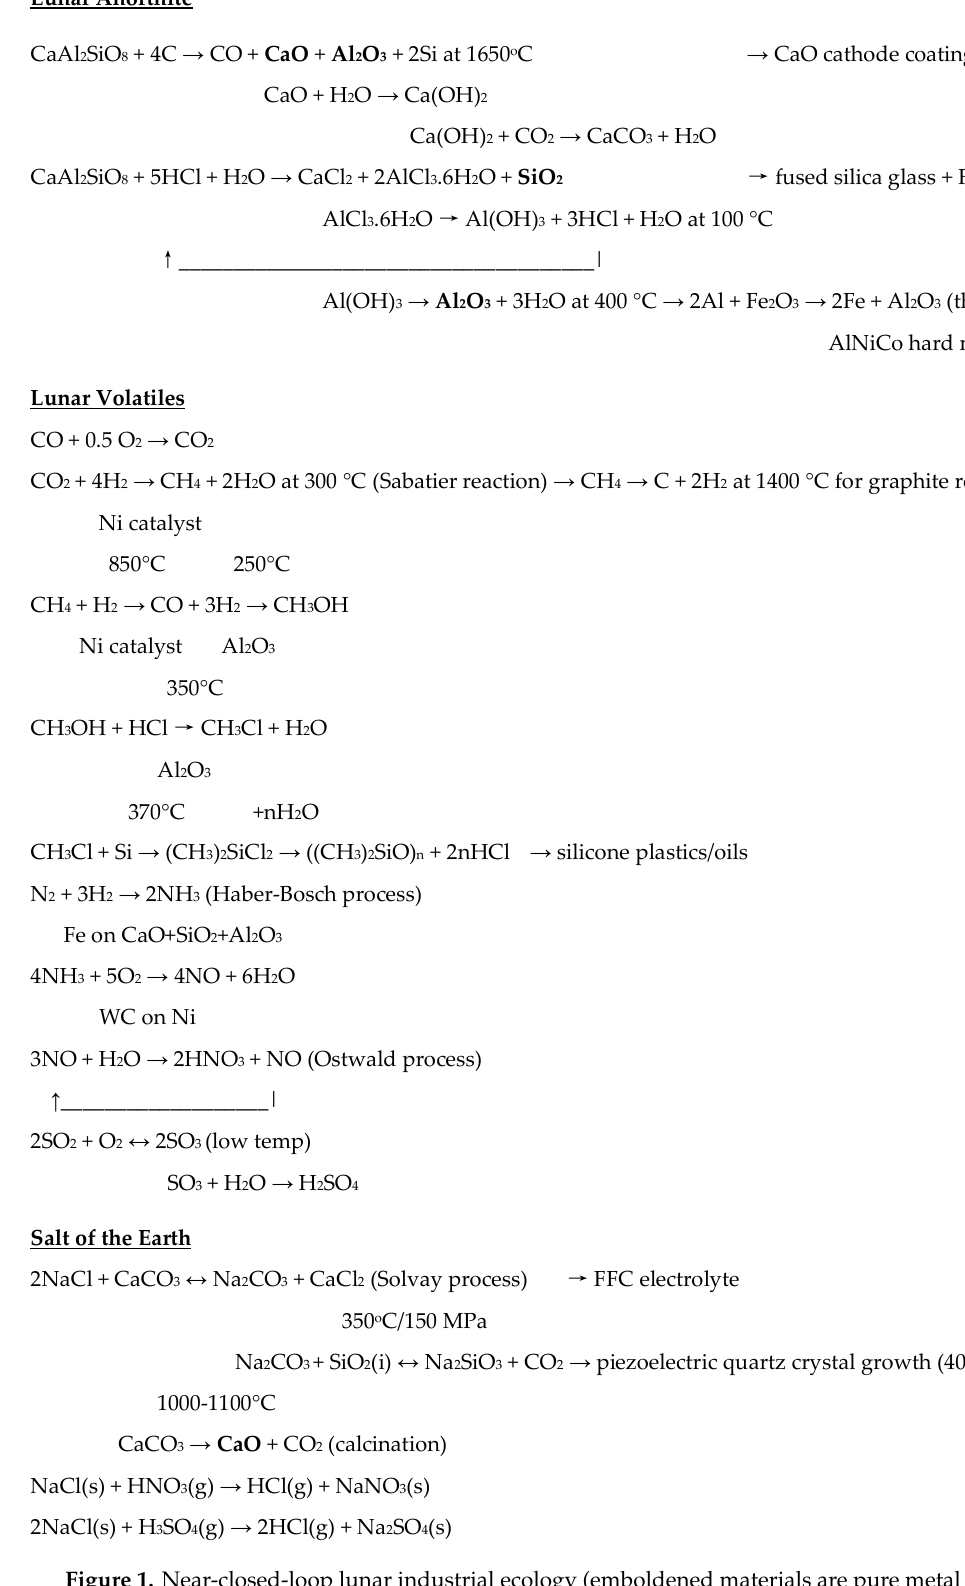
Figure 1. Near-closed-loop lunar industrial ecology (emboldened materials are pure metal oxides for direct reduction using the Metalysis FFC process).